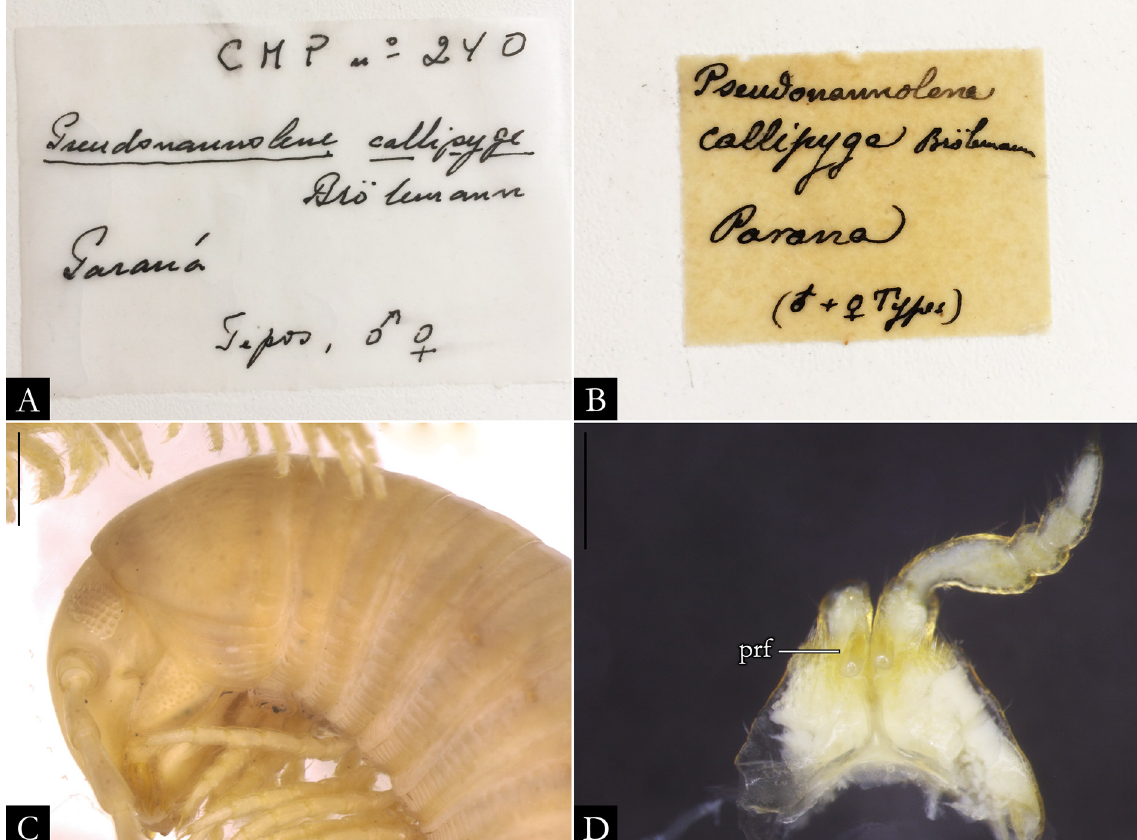
Fig. 60. Pseudonannolene callipyge Brölemann, 1902, ♂ (MZSP). A–B . Original label of type material. C . Anterior region. D . First leg-pair. Abbreviation: see Material and methods. Scale bars: C = 1 mm; D = 0.5 mm.